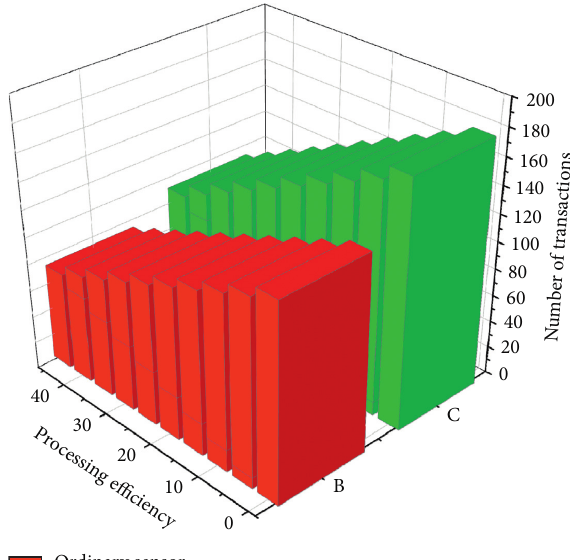
Figure 6: Efficiency graph after conversion.